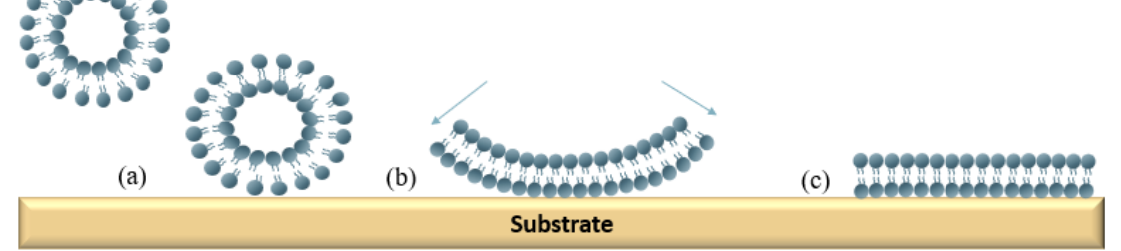
Figure 3. A schematic presentation of the vesicle fusion process for the formation of the supported lipid bilayer (SLB). ( a ) Small unilamellar vesicles are adsorbed to the substrate surface. ( b ) The fusion of small unilamellar vesicles occurs. ( c ) A continuous lipid bilayer is formed by the spread of the small patches.